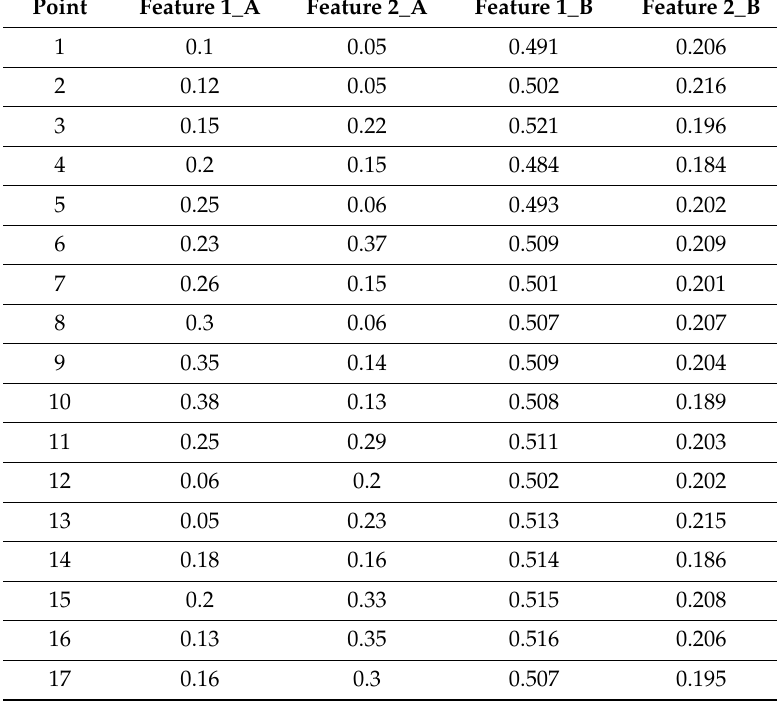
Table A1. Values of feature 1 and 2 for 30 samples from A and B